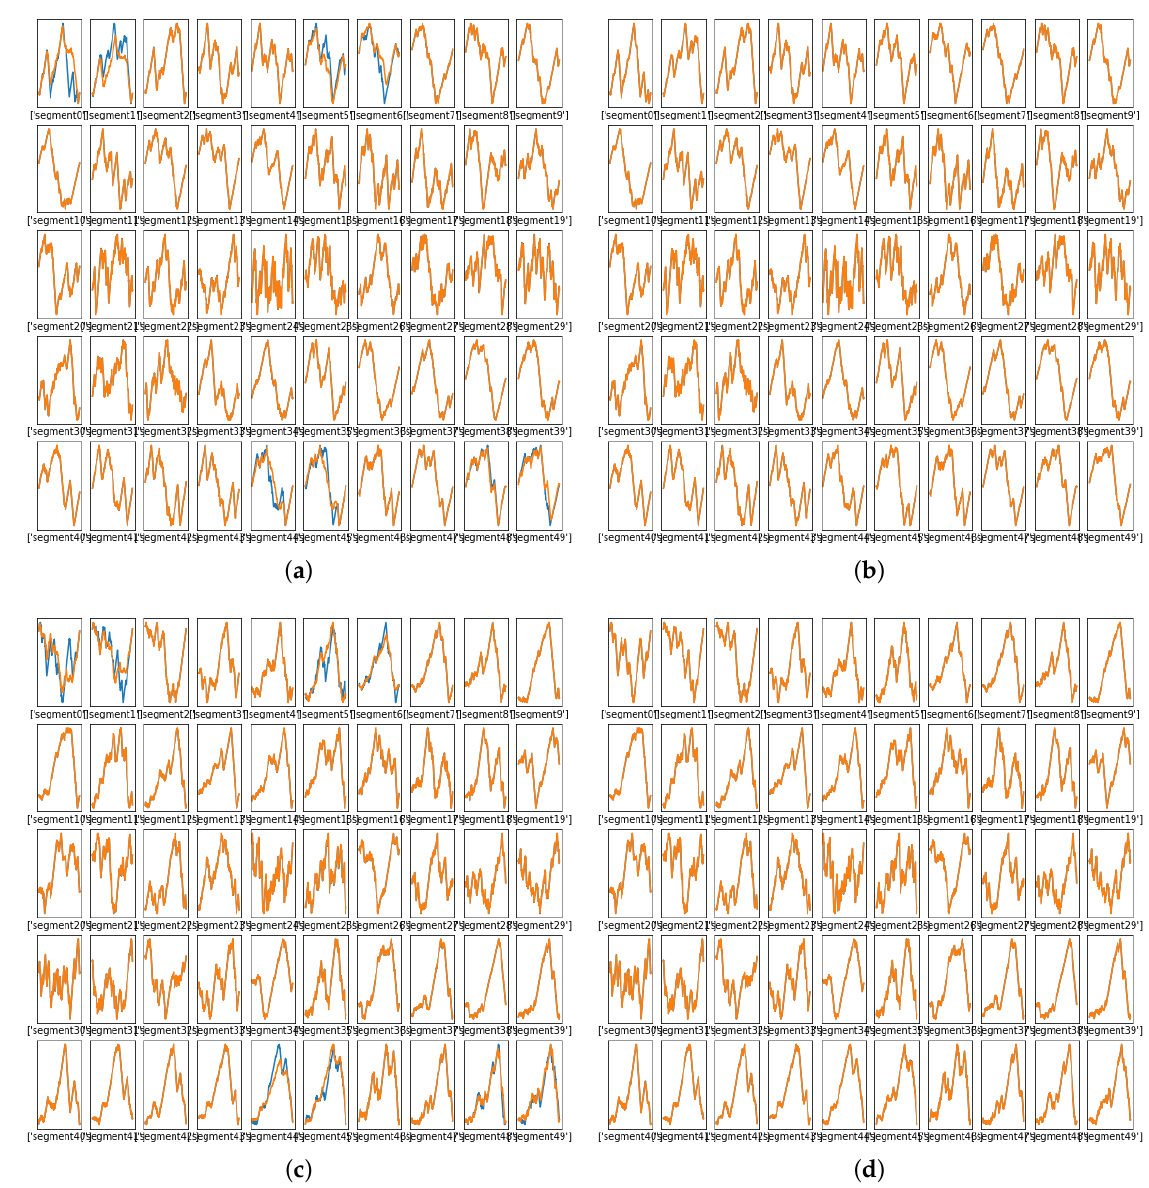
Figure 10. Learned warping paths, phase one, 5000 training iterations. ( a ) Warping path a produced using 1-IP/1-OP architecture. ( b ) Warping path a produced using 3-IP/1-OP architecture. ( c ) Warping path b produced using 1-IP/-1-OP architecture. ( d ) Warping path b produced using 3-IP/1-OP